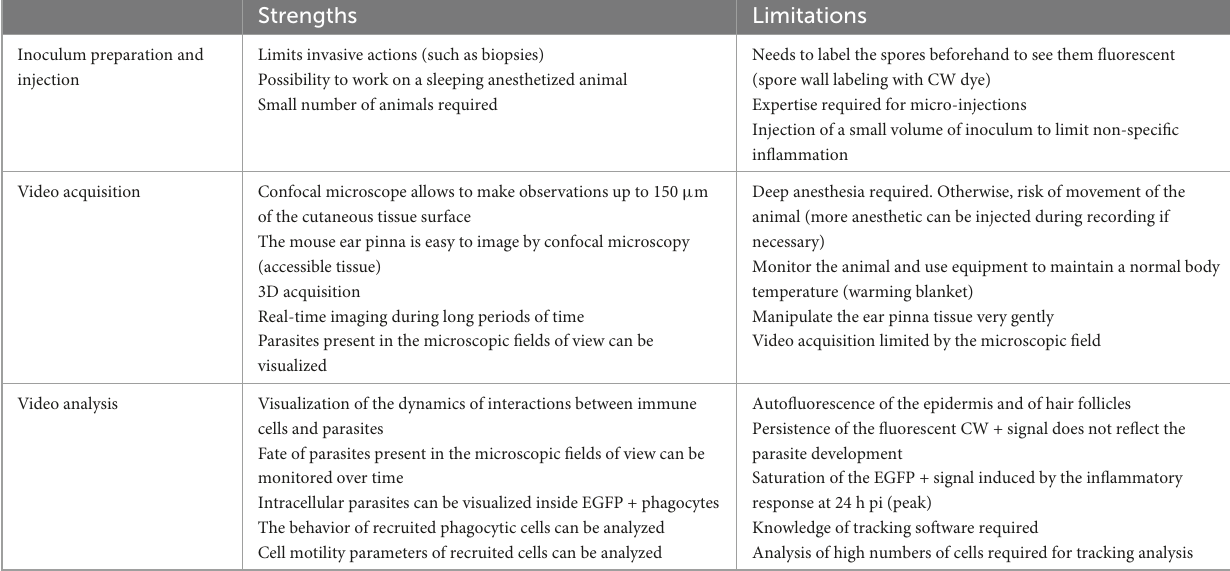
TABLE 1 Critical points of the mouse ear skin model to study the dynamics of immune responses against Encephalitozoon cuniculi parasites 1 .